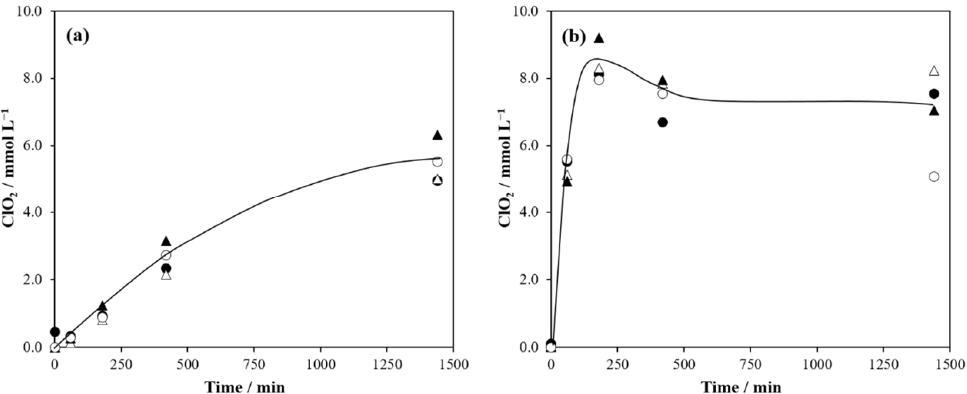
Figure 1. Time-course of the production of chlorine dioxide in the liquid reaction mixture: ( a ) 10 mL of chlorate (5 g L − 1 ), 6 mL of hydrogen peroxide (3300 mg L − 1 ) and 25 mL of sulfuric acid (5.0 M) at 50 °C, ( b ) 10 mL of chlorate (5 g L − 1 ), 4 mL of hydrogen peroxide (3300 mg L − 1 ) and 25 mL of sulfuric acid (5.0 M) at 83 °C. Number of repetitions: 4. Legend Figure 1a: Test Q1 ( ● ), test Q2 ( △ ), test Q3 ( ▲ ) and test Q4 ( ○ ). Legend Figure 1b: Test Q5 ( ● ), test Q6 ( ∆ ), test Q7 ( ▲ ) and test Q8 ( ○ ).